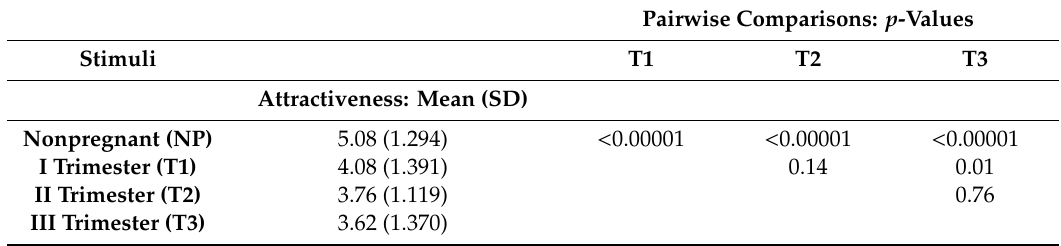
Table 2. Post hoc Tukey’s HSD pairwise comparisons of attractiveness